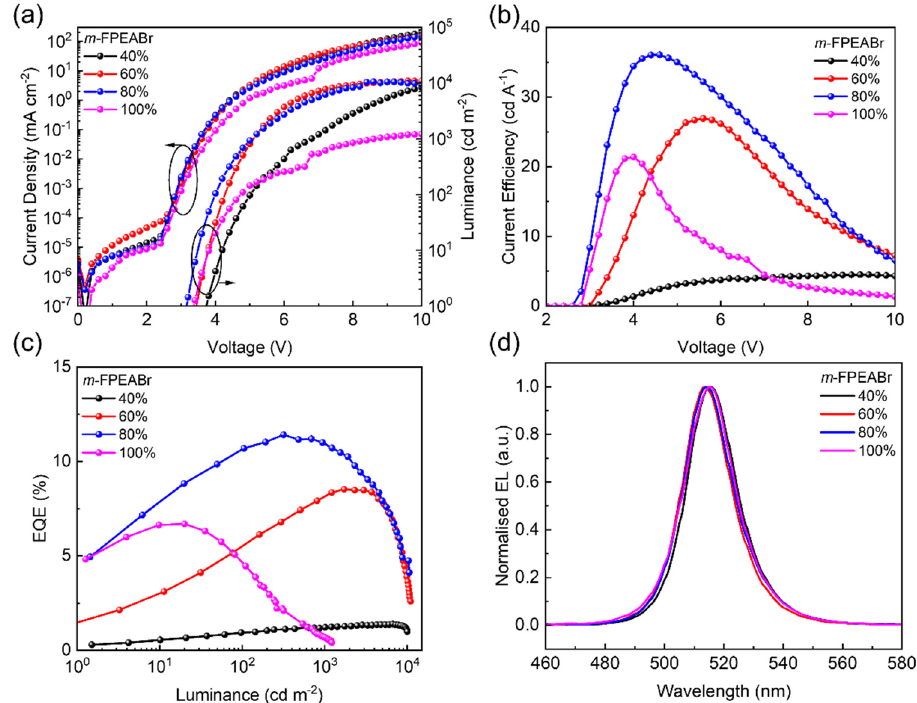
Figure 2. Performance of quasi-2D PeLEDs based on different contents of m -FPEABr at 110 °C annealing temperature. ( a ) Current density-voltage-luminance (J-V-L) characteristics. ( b ) Current efficiency-voltage (CE-V) characteristics. ( c ) EQE-luminance (EQE-L) characteristics. ( d ) EL spectra at 6V.